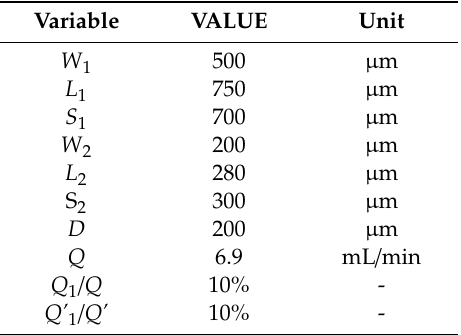
Table 1. Variables of the pm air-microfluidic chip design.